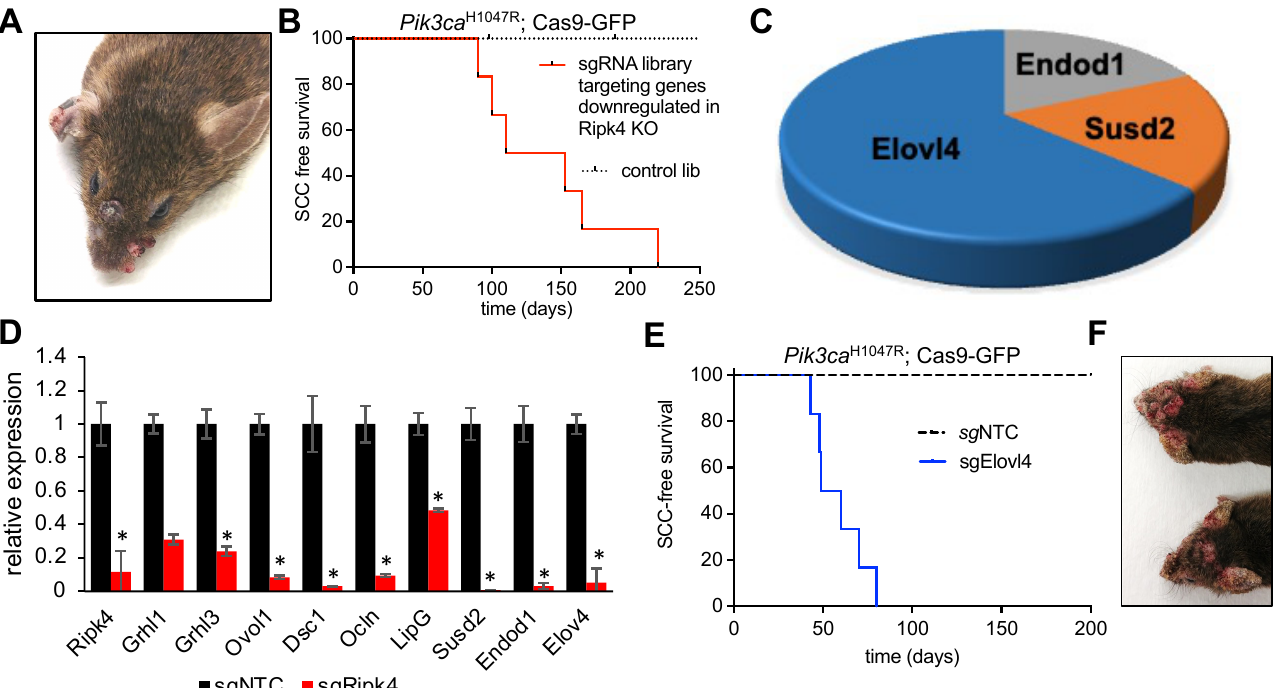
Figure 3. Elovl4 is a tumor suppressor downstream of Ripk4. ( A ) Representative image of tumors in an LSL- Pik3ca H1047R ; LSL-Cas9-GFP mouse transduced with LV carrying Cre recombinase and sgRNAs targeting the genes downregulated in Ripk4-deficient keratinocytes. ( B ) Tumor-free sur- vival for LSL-Pik3ca H1047R ; LSL-Cas9-GFP mouse transduced with downregulated genes library ( n ≥ 8 per group; p < 0.0001, log-rank test). ( C ) Pie chart showing the genes that have their corre- sponding sgRNAs enriched in the tumors collected from mice transduced with the CRISPR gene library targeting downregulated Ripk4 target genes. ( D ) Real-time PCR results showing relative expression of indicated genes in mouse keratinocytes carrying CRISPR/Cas9-mediated ablation of Ripk4 when compared to non-targeting control. Data are shown as means ± SEM ( n = 3). * Denotes p -value < 0.05. ( E ) Tumor-free survival for tumor-prone Pik3ca H1047R ;Cas9 mice transduced with an independent sgRNA against Elovl4. sgNTC served as a control ( n ≥ 5 per group; p < 0.0001, log-rank test). ( F ) Representative images of tumors in the head and neck region of Pik3ca H1047R ; Cas9 mice transduced with sgElovl4